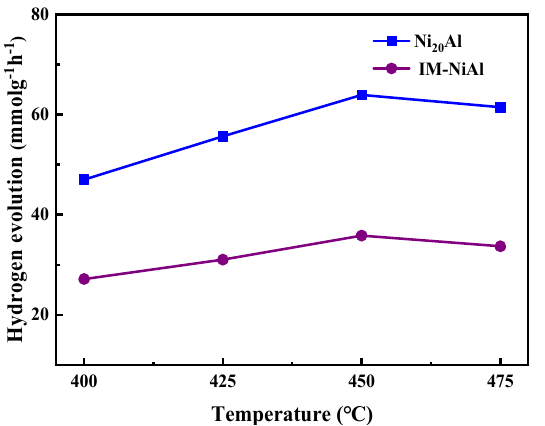
Figure 7. Hydrogen release rates over the Ni 20 Al and IM-NiAl catalysts at different temperatures.